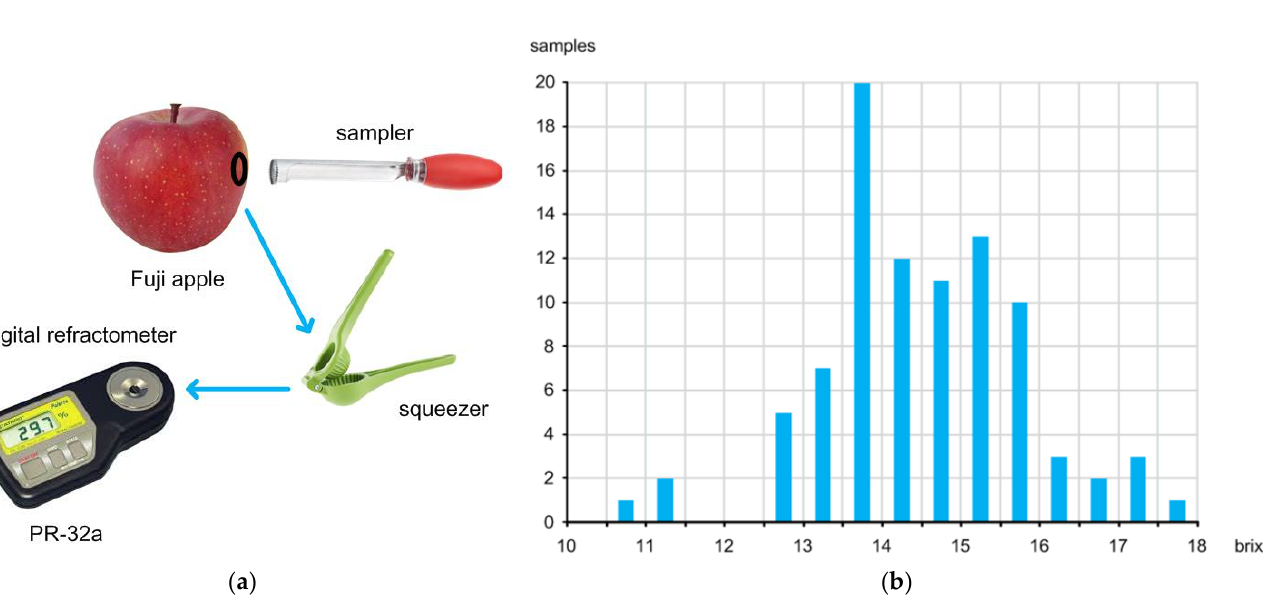
Figure 2. ( a ) Direct sugar content measurement setup using a digital refractometer and ( b ) distribution of measured sugar content values.